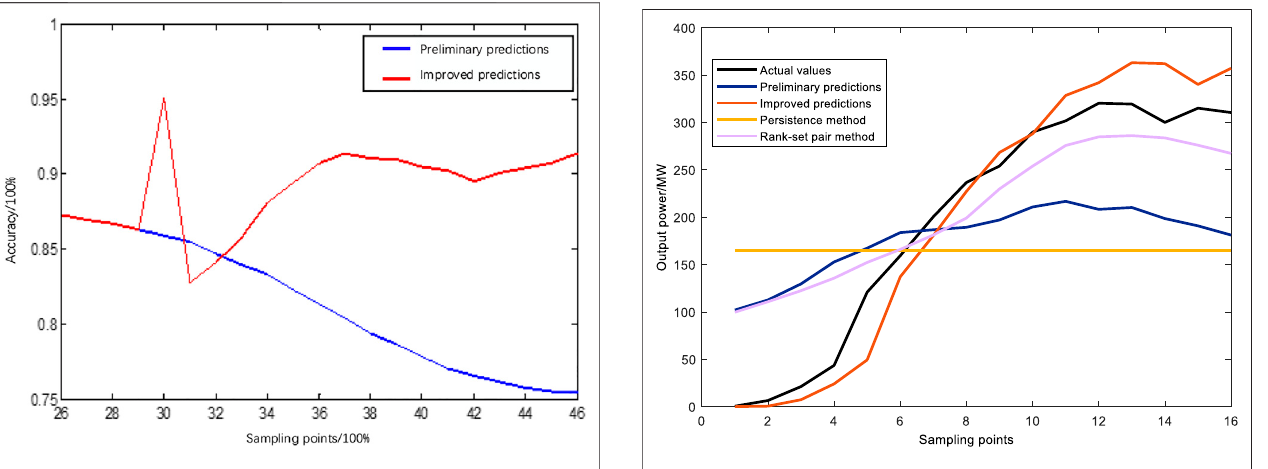
FIGURE 16 | Comparison of predictions for the morning phase yielded by different